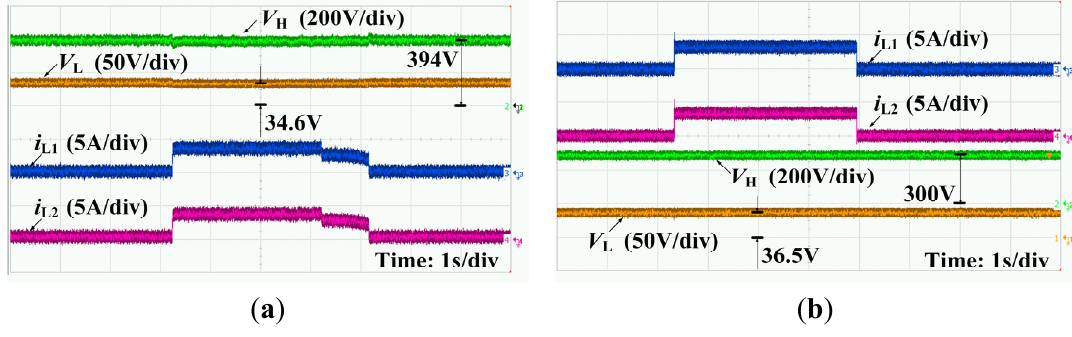
Figure 20. Dynamic response of the proposed BDC against load variation ( a ) load resistance variation between 10 k Ohm and 320 Ohm; ( b ) load resistance variation between 100 Ohm and 2.5 Ohm.